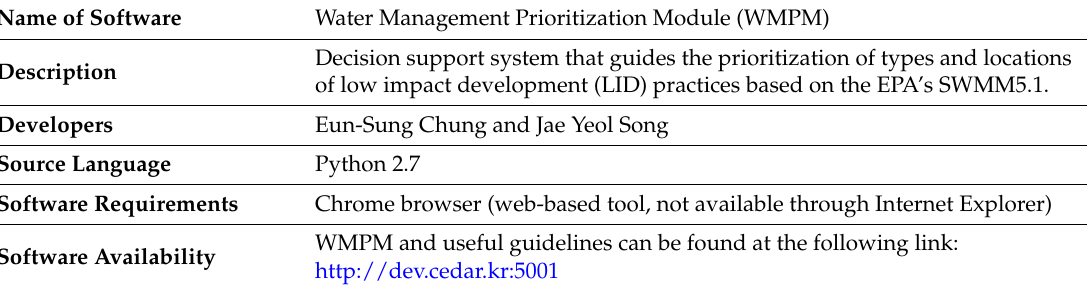
Table A1. Software